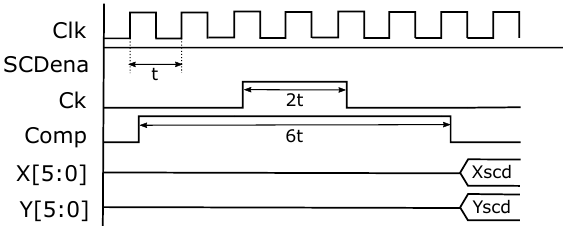
Figure 5. Sensor protocol and timing.